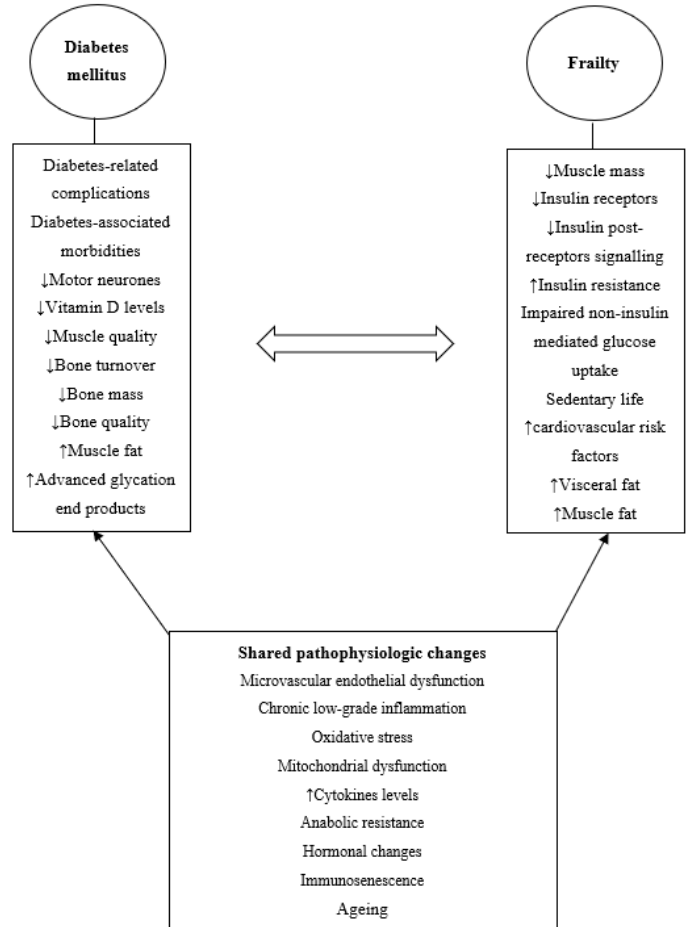
Figure 1. Bidirectional relationship between diabetes mellitus and frailty.